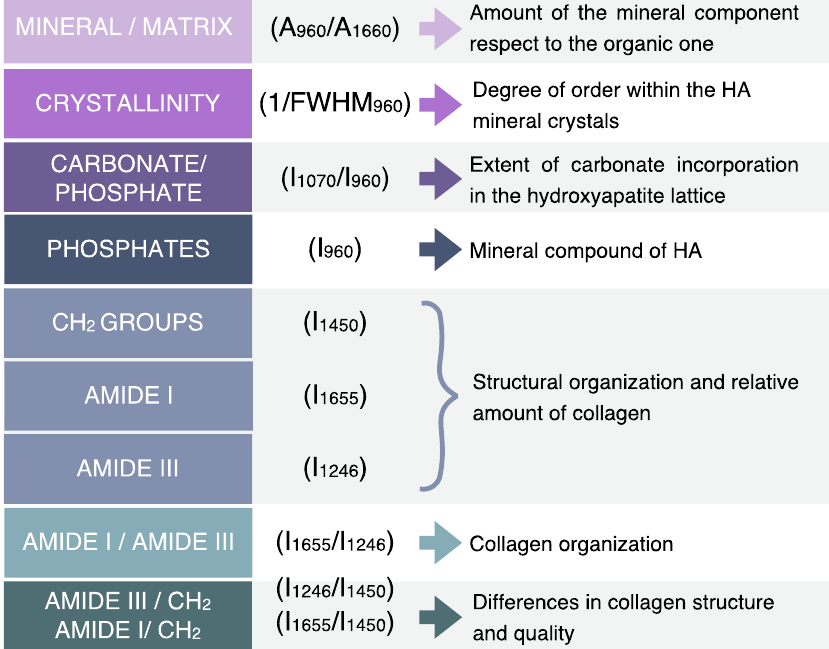
Figure 2. Raman-derived markers for the characterization of hard dental tissues (I: intensity of the band; A: area of the band; and FWHM: full width at half